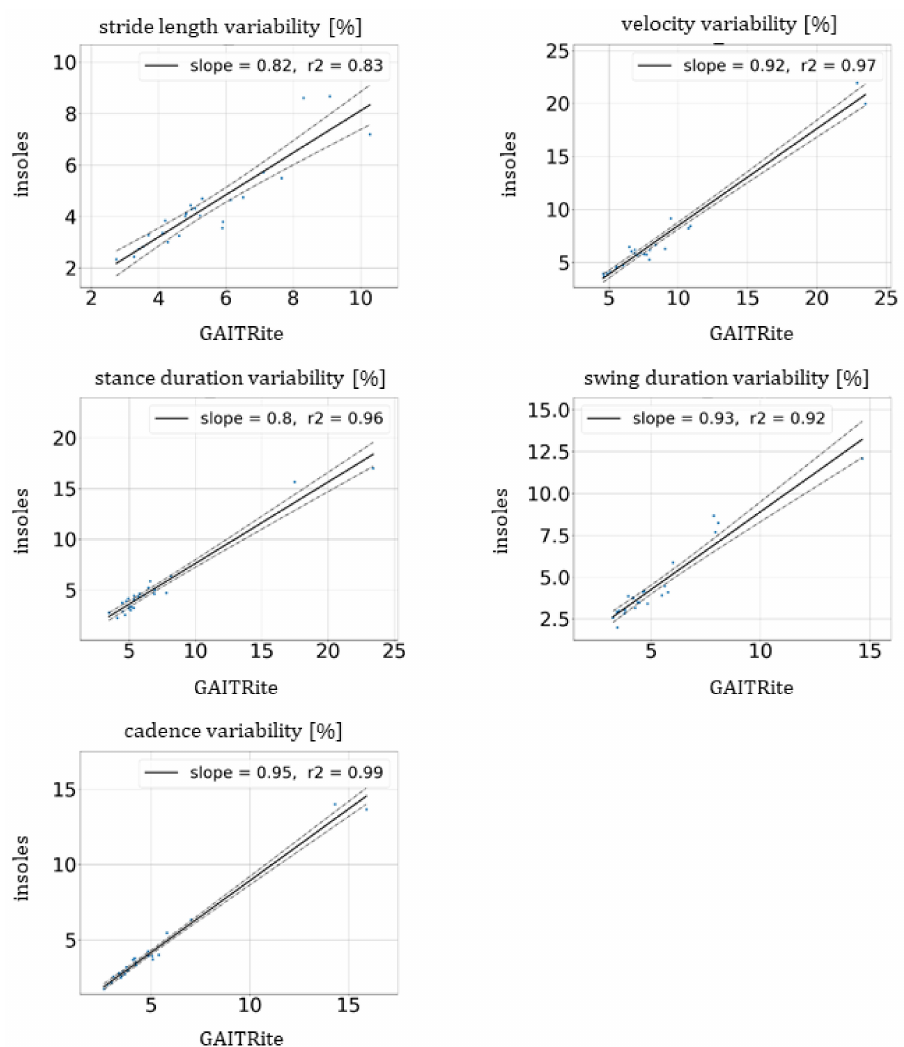
Figure 4. Linear regression of estimates of variability (coefficient of variation) of unipedal gait parameters for velocity, stride length, stance and swing duration and cadence between GAITRite ® mat and the insoles (solid lines). The dashed lines represent the confidence region. The values of the slope and the coefficient of determination, r 2 , are provided in the